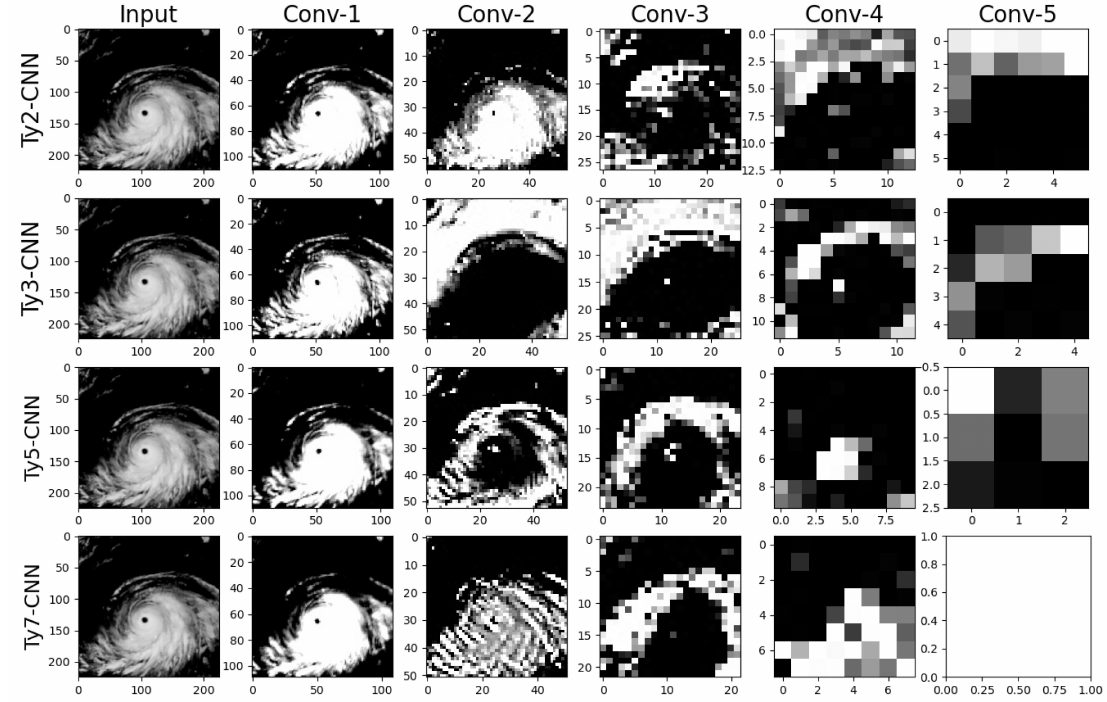
Figure 4. Feature extraction results of different convolution kernels for a super